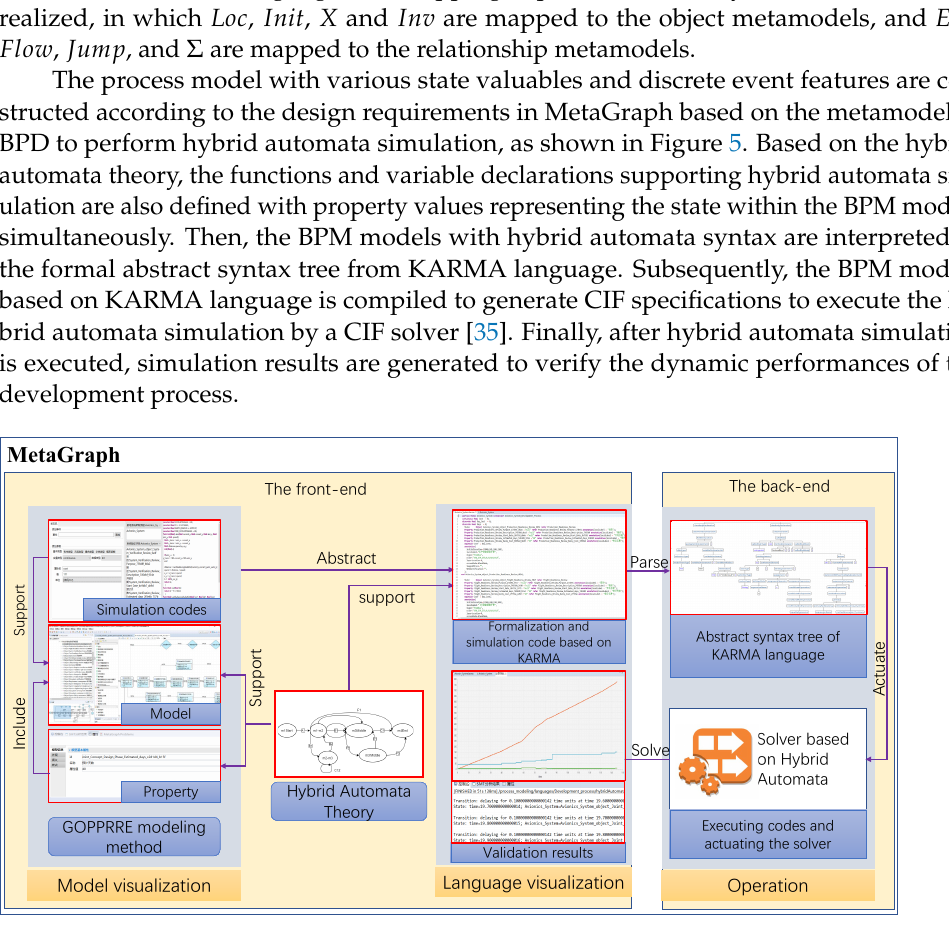
Figure 5. Implementation of the hybrid automata simulation for the process